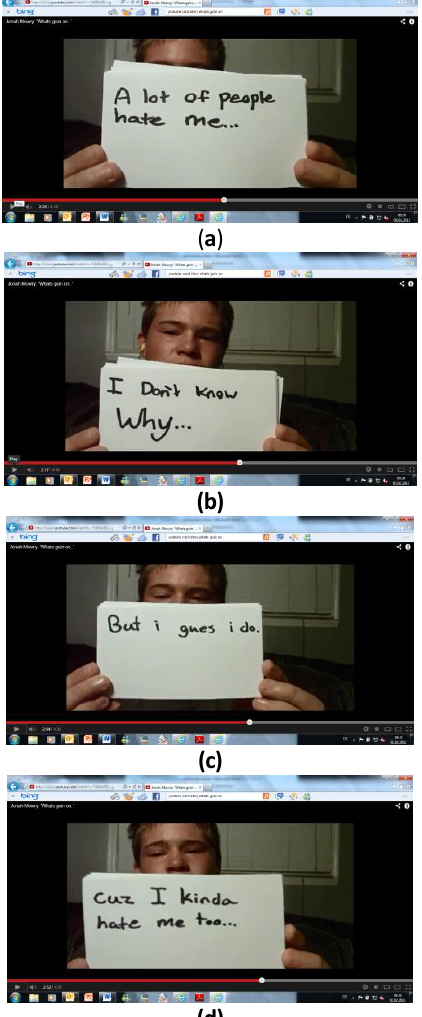
Figure 2 (a–d). Main part of the video. Source: